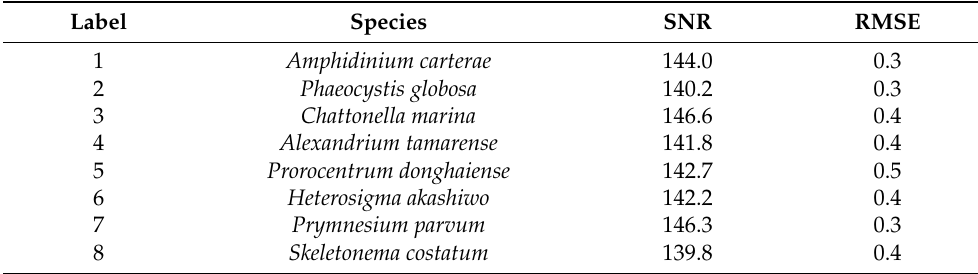
Table 3. Denoising effect of selected algae based on a discrete wavelet transformation (DWT) fil- ter.